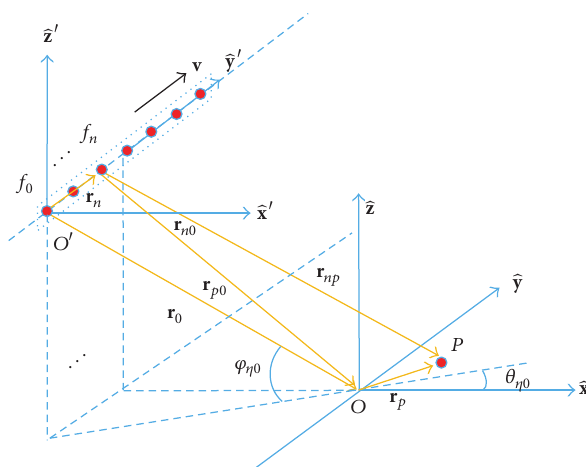
Figure 8: Imaging geometry of the frequency stepped